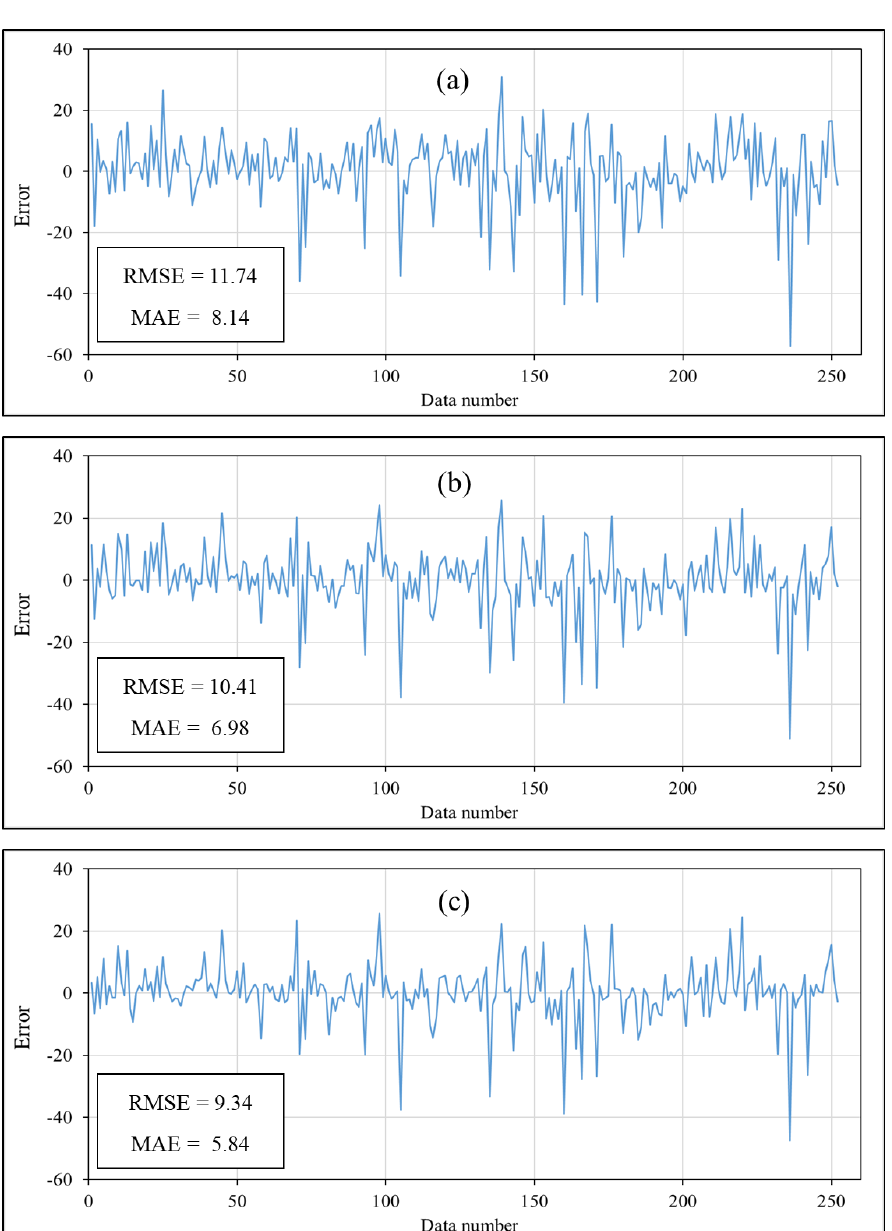
Figure 6. The training results of the implemented ( a ) typical ANN, ( b ) SFLA – ANN, and ( c ) WDO – ANN.